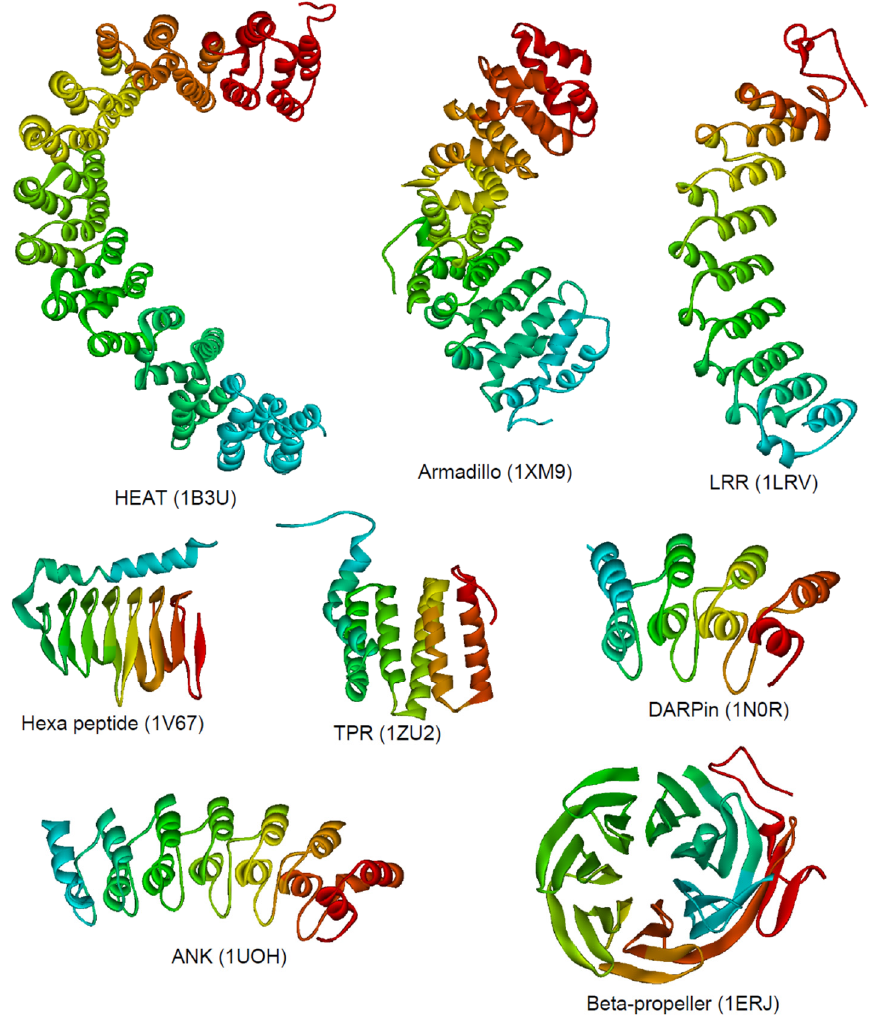
Figure 1. Structural architecture of various repeat proteins. The backbone is depicted from the N-terminus (red) to the C-terminus (cyan) for the HEAT repeat protein phosphatase 2A PR65/A subunit [17] , the armadillo repeat domain of plakophilin 1 [18] , an leucine-rich repeat variant [19] , the hexa peptide repeat gamma-class carbonic anhydrase [20] , the TPR repeat domain of TOM20 [21] , DARPin [22] , the ankyrin repeat protein gankyrin [23] , and the beta propeller domain of Tup1 [24] . The PDB ID is given below the structure.